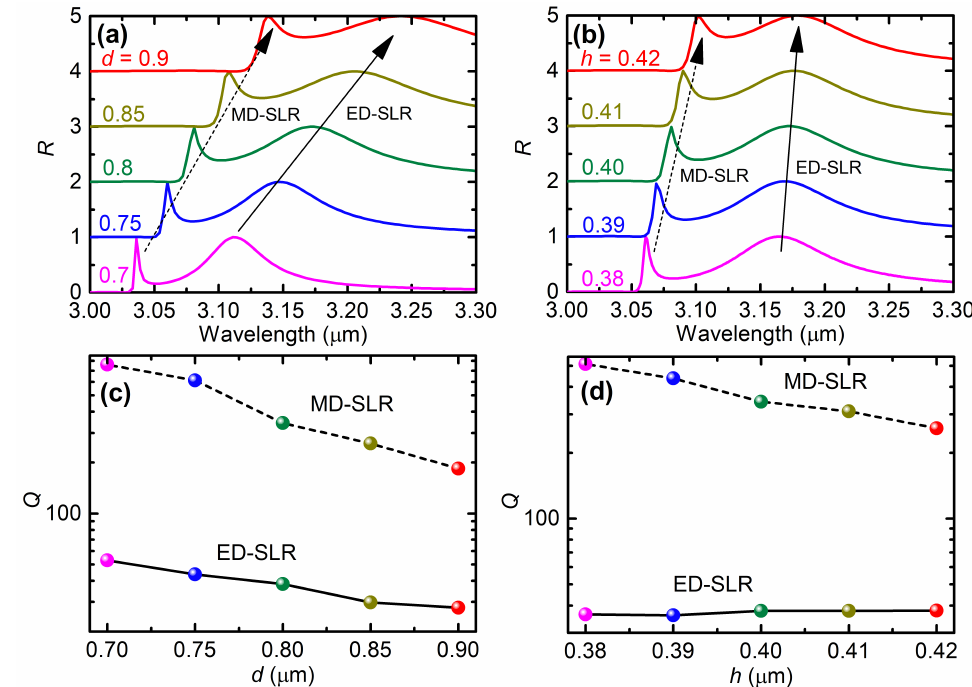
Figure 5. ( a , b ) Simulated reflectance spectra and ( c , d ) the associated quality factors of ED-SLR and MD-SLR for different ( a , c ) diameters and ( b , d ) heights (the values of both parameters are in units of